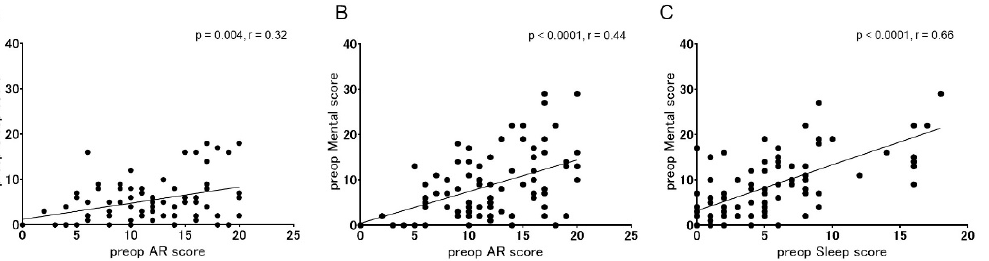
Figure 1. Correlations between preoperative AR, sleep, and mental scores in all the subjects. ( A ) correlation between AR and sleep scores, ( B ) correlation between AR and mental scores, ( C ) correlation between sleep and mental scores. Significant correlations among AR, sleep, and mental scores were observed with the Spearman rank correlation ( p = 0.004, r = 0.32 for AR and sleep scores; p < 0.0001, r = 0.44 for AR and mental scores; p < 0.0001, r = 0.66 for sleep and mental scores).